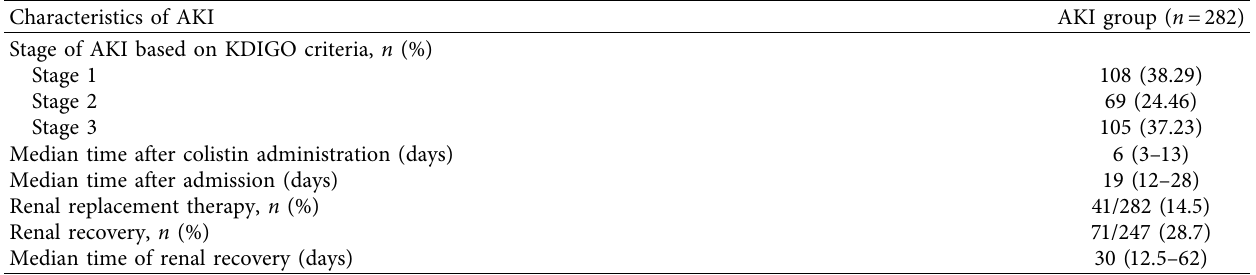
Table 3: Characteristics of acute kidney injury after administration of